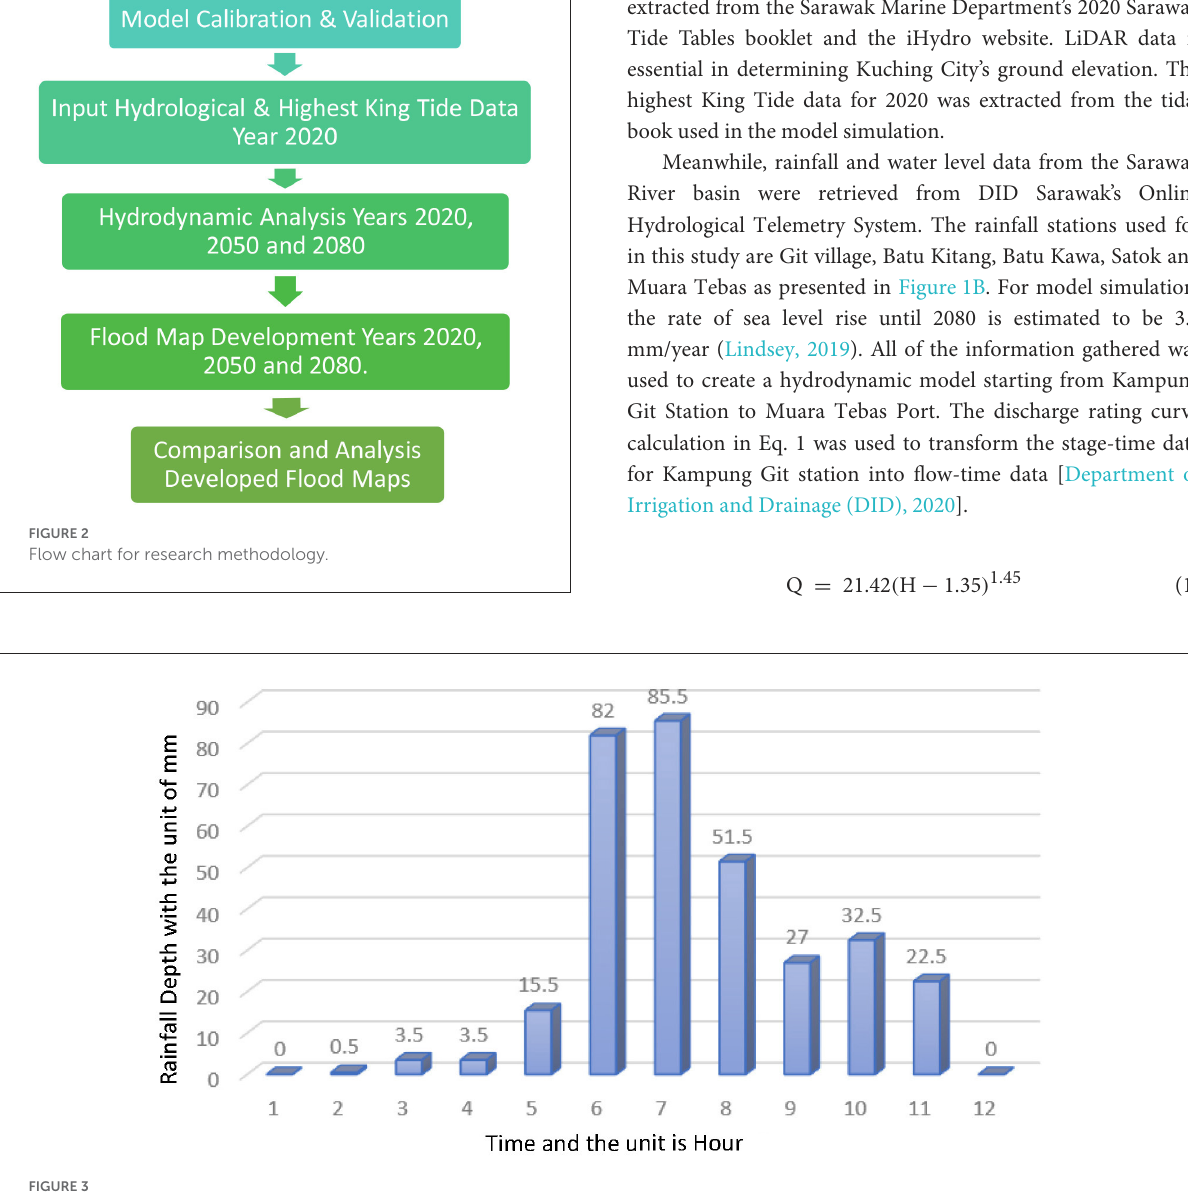
FIGURE3 Extreme heavy rainfall with 50-year ARI on 10 Jan